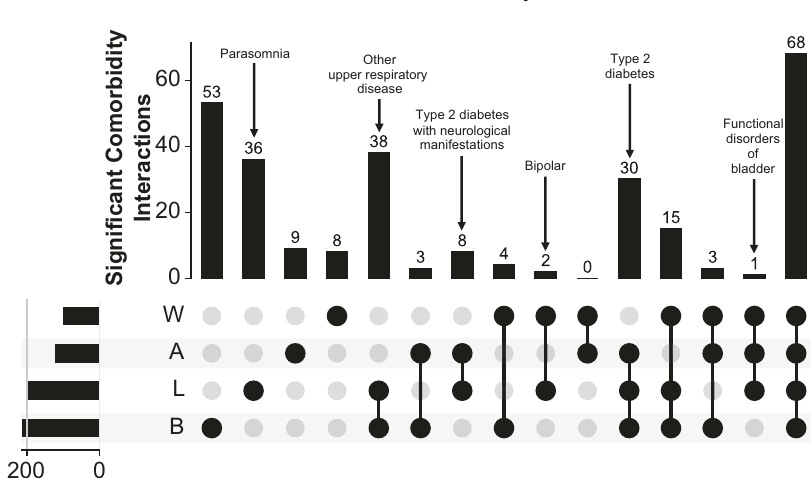
Fig. 3 AD-associated comorbidities are often signi fi cant for all racialized populations. Upset plot of signi fi cant comorbidity intersections across racialized populations with AD at UCSF. Rows indicate each racialized population analyzed. Bar chart shows single and overlapping signi fi cant comorbidities across racialized populations. AD Alzheimer ’ s dementia, A Asian-identi fi ed patients, B Black-identi fi ed patients, L Latine-identi fi ed patients, W White-identi fi ed patients, AD Alzheimer ’ s dementia, UCSF University of California San Francisco. Statistical signi fi cance was determined using two- sided Fisher ’ s exact or chi-squared tests, comparing 931 phenotypes between patients with AD ( n = 422) and control patients ( n = 844) within each racialized population. Signi fi cance corresponds to a Bonferroni-corrected p -value <